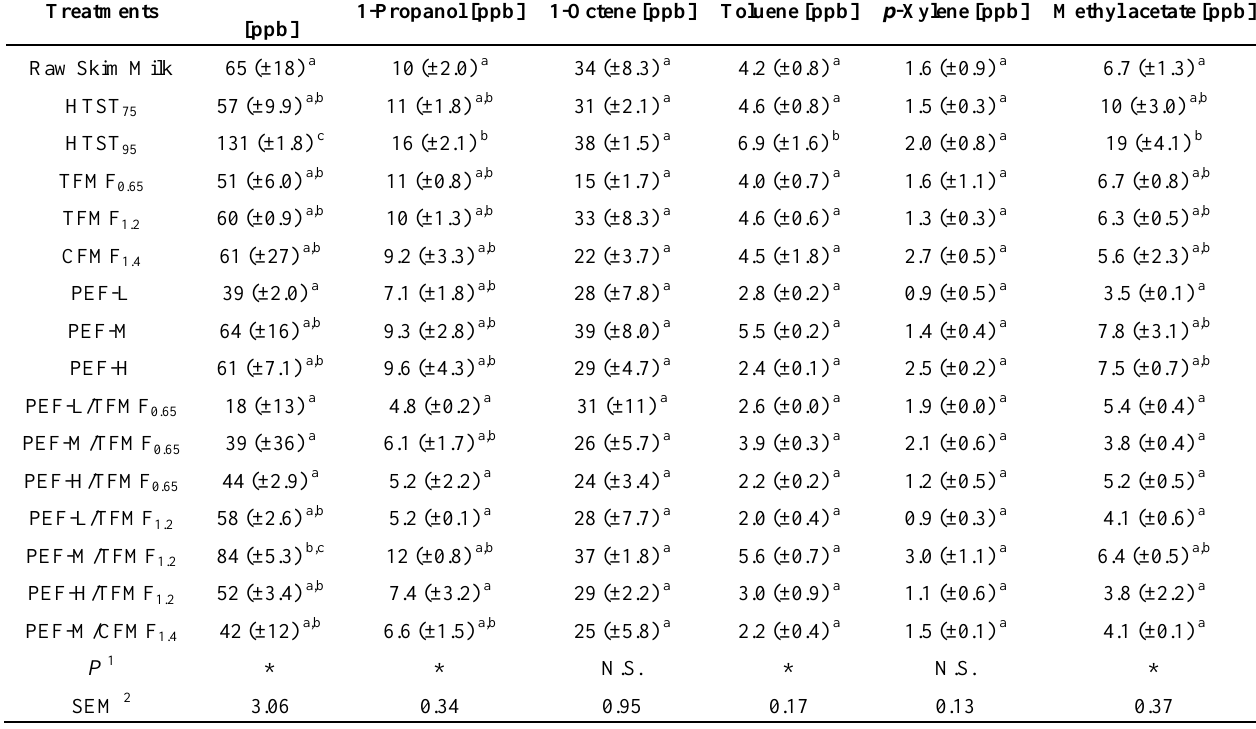
Table 3. Retention of in ethanol, 1-propanol, 1-octene, toluene, p -xylene, and methyl acetate obtained in skim milk after high-temperature short-time pasteurization (HTST = 75 °C for 75 and lab-scale tangential-flow